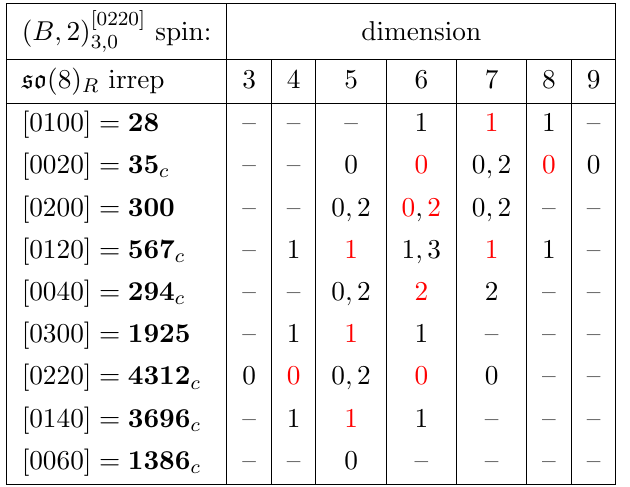
Table 23 . All possible conformal primaries in S 3 (cid:2) S 3 corresponding to the ( B; 2) [0220] formal multiplet.